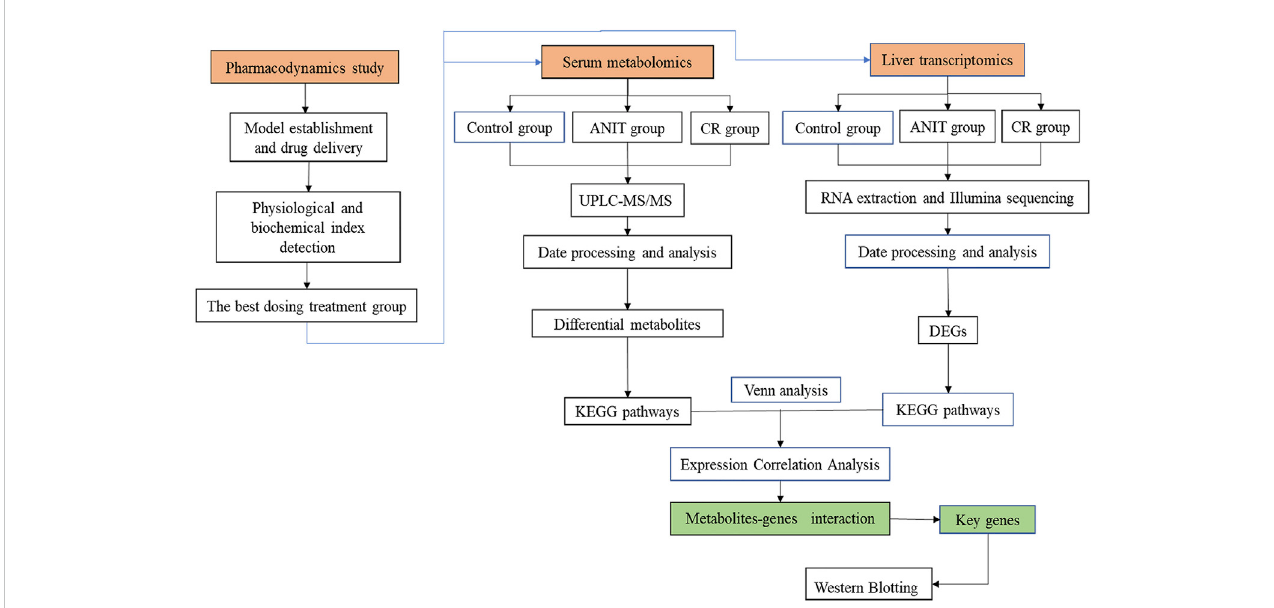
FIGURE 2 The schematic fl owchart of the integrated